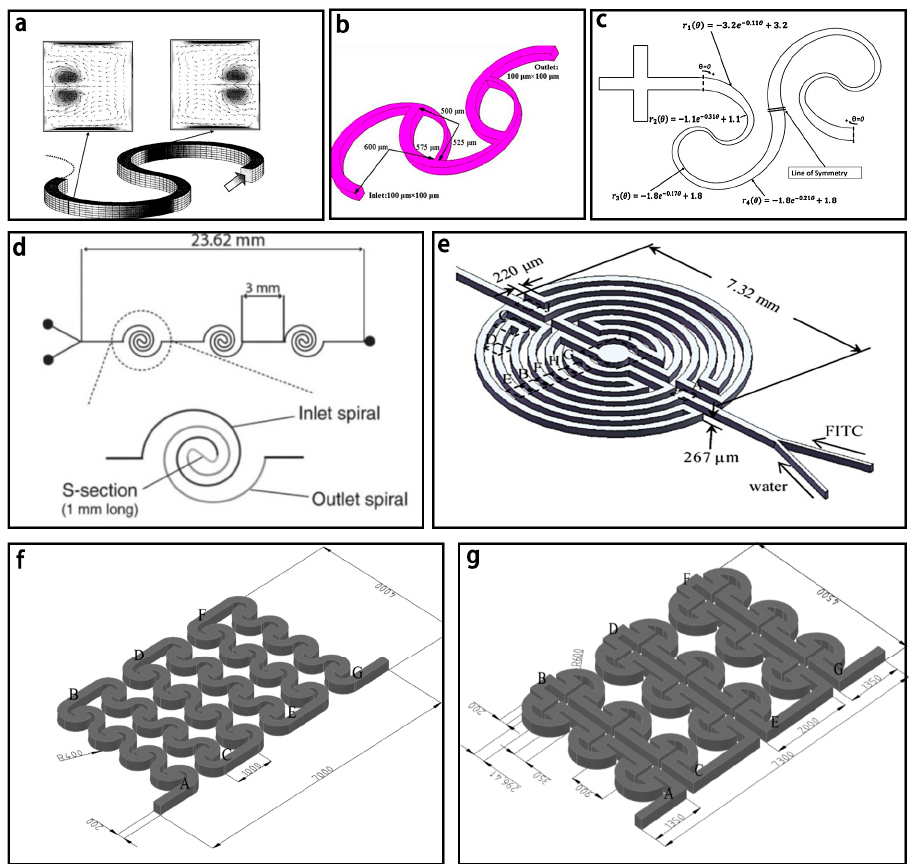
Figure 13. ( a ) Schematic of the spiral micromixer (The arrow indicates the flow direction); ( b ) Schematic of the parallel laminar micromixer; ( c ) Schematic of the spiral based micromixer with sequential logarithmic structure; ( d ) Schematic of the double spiral based micromixer; ( e ) Schematic of the labyrinth-like multiple spiral based micromixer; ( f ) Schematic of the spiral based micromixers with interlocking semicircles; ( g ) Schematic of the spiral based micromixers with omega-shaped channels. Reproduced with permission from [114,132–135].